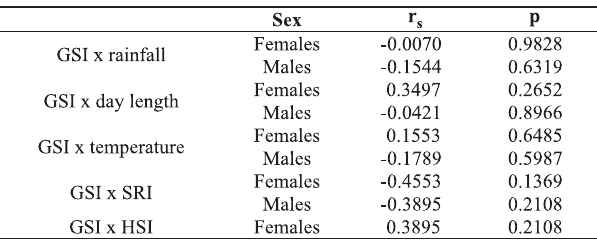
Table 2. Spearman correlation test among mean valves of GSI (gonadosomatic index) and rainfall, day length, tem- perature, SRI (stomach repletion index) and HSI (hepatosomatic index) data from April 2001 to March 2002 for females and males of Bryconamericus iheringii from rio Vacacaí, RS, Brazil.